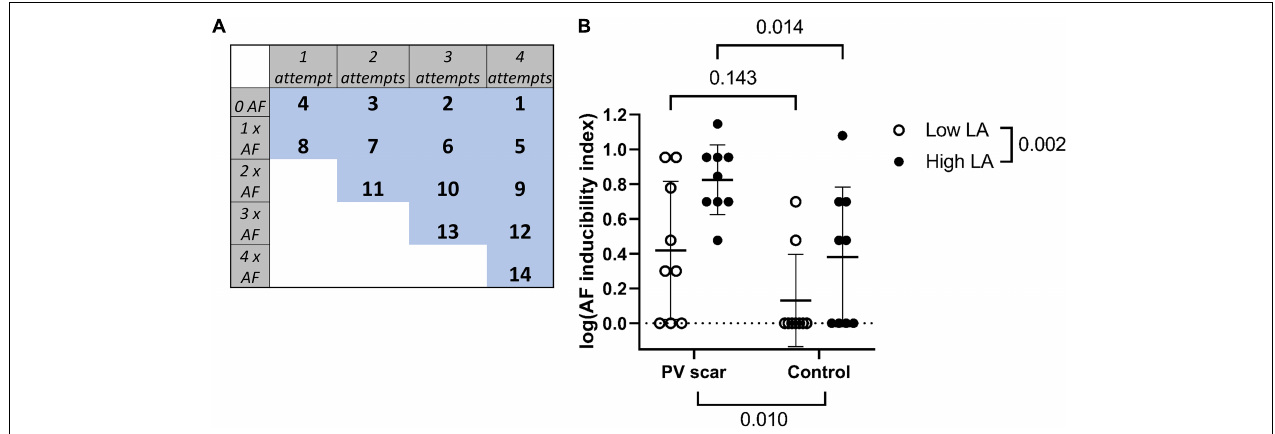
FIGURE 4 | AF induction. (A) An AF inducibility index was calculated in low and high LA pressure in each heart based on the number of induction attempts performed and the number of attempts inducing AF. Maximum 4 induction attempts were performed in each pressure in each heart (2 in RPV and 2 in LPV). (B) The AF inducibility index in high LA pressure was significantly increased in PV scar hearts compared with control hearts ( n = 9 vs. n = 9, respectively, p = 0.014; Bonferroni correction applied after a two-way repeated measures ANOVA. Overall PV scar effect p = 0.010 and overall LA pressure effect p = 0.002. A logarithmic transformation of the index values was performed before statistical testing.